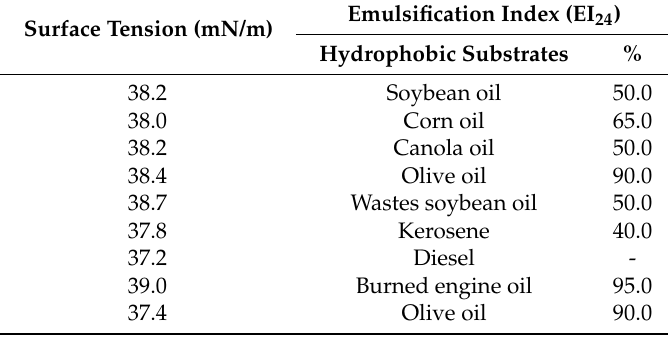
Table 2. The surface tension and the emulsification index (EI 24 ) for different hydrophobic substrates that were obtained by the bioemulsifier produced from Bacillus subtilis UCP 0146 in a medium containing cassava